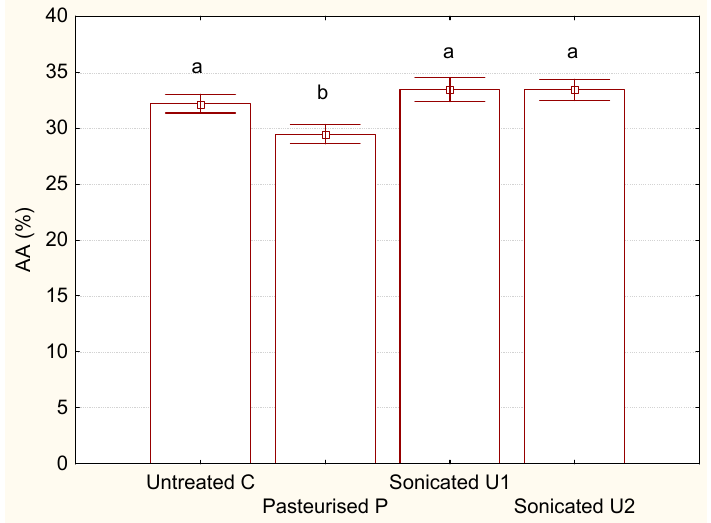
Figure 7. Effect of preservation method on antioxidant activity of apple juice. Error bars represent standard deviations. Values that share the same letter are not significantly different at P < 0.05.